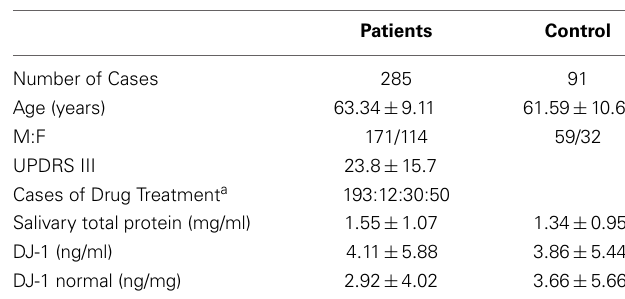
Table 2 | Summary of demographics and salivary DJ-1 levels in a large